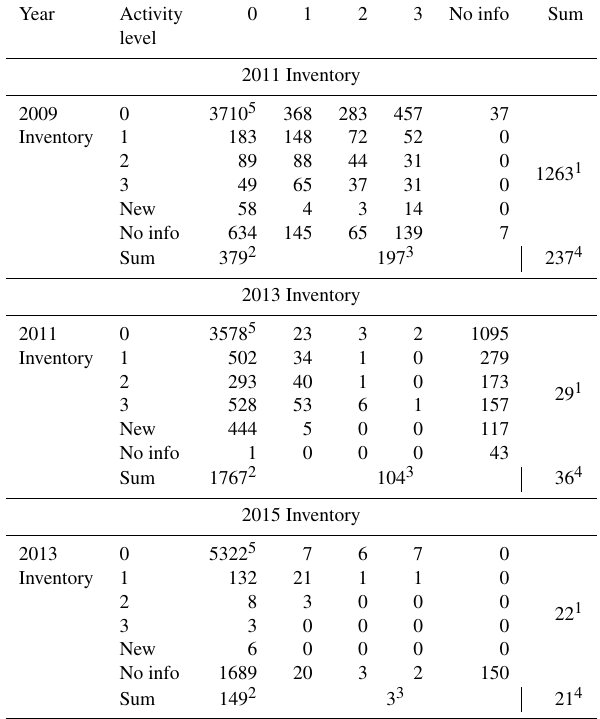
Table 7. Changes in landslide activity level of the consecutive years. 1 Total number of landslides with increased activity level compared with the previous period. 2 Number of landslides that became dor- mant. 3 Number of landslides with decreased activity level, exclud- ing dormant. 4 Number of landslides with the same activity level as the previous period. 5 Number of landslides that remain dormant in both inventories. The number mismatches were caused by small landslides that were ignored by ArcMap software during rastering of the inventories to do this analysis.